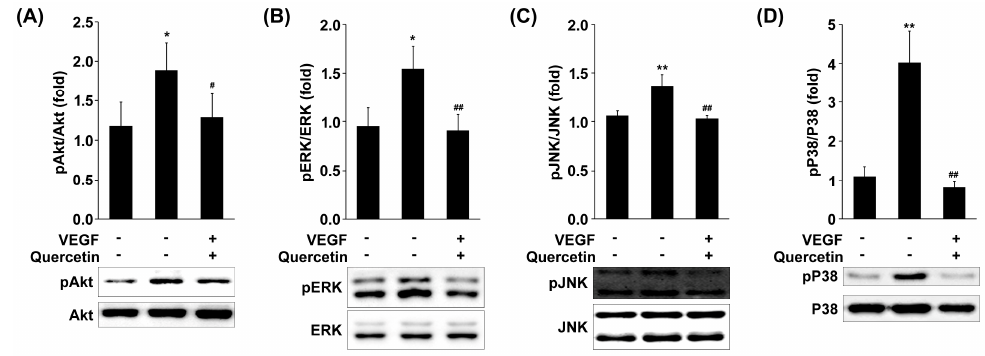
Figure 7. Effect of quercetin on the phosphorylation of MAPKs and Akt in VEGF-stimulated 661W cells. Cells were treated with VEGF (20 ng/mL) in the absence or presence of quercetin (0.1 µM) for 1 h. The phosphorylation levels of ERK ( A ), JNK ( B ), p38 ( C ), and Akt ( D ) were detected by immunoblot using corresponding antibodies. Densitometry quantifications of protein expression were measured by ImageJ. Data are the means ± SDs of three independent experiments. * p < 0.05 and ** p < 0.01 indicate significant differences compared to the non-treated control group. # p < 0.05 and ## p < 0.01 indicate significant differences compared to the VEGF-only treated group.